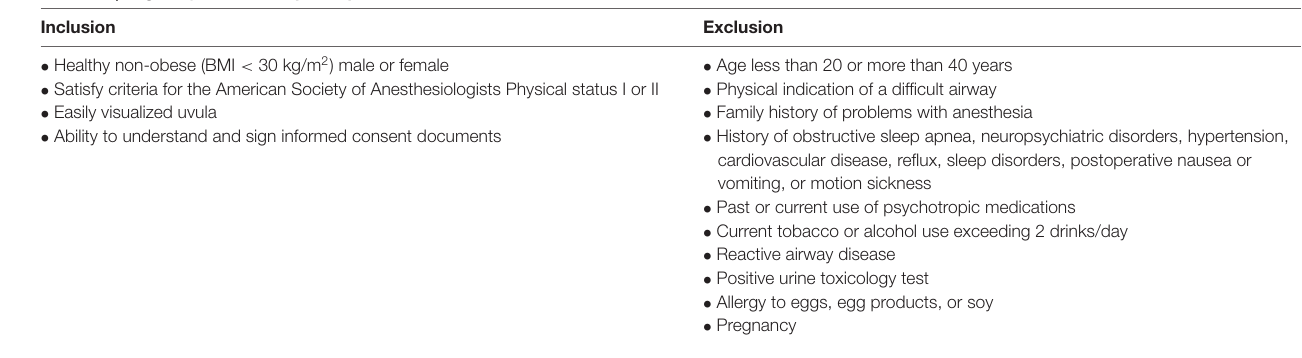
TABLE 1 | Eligibility criteria for